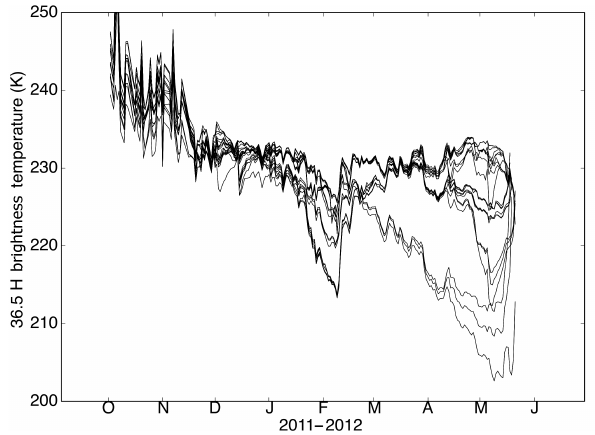
Figure 6. Variability in brightness temperature simulated with em- pirical MEMLS, driven by the MOSES microstructure model and 63 JIM snowpack outputs (no scaling of microstructure was re-